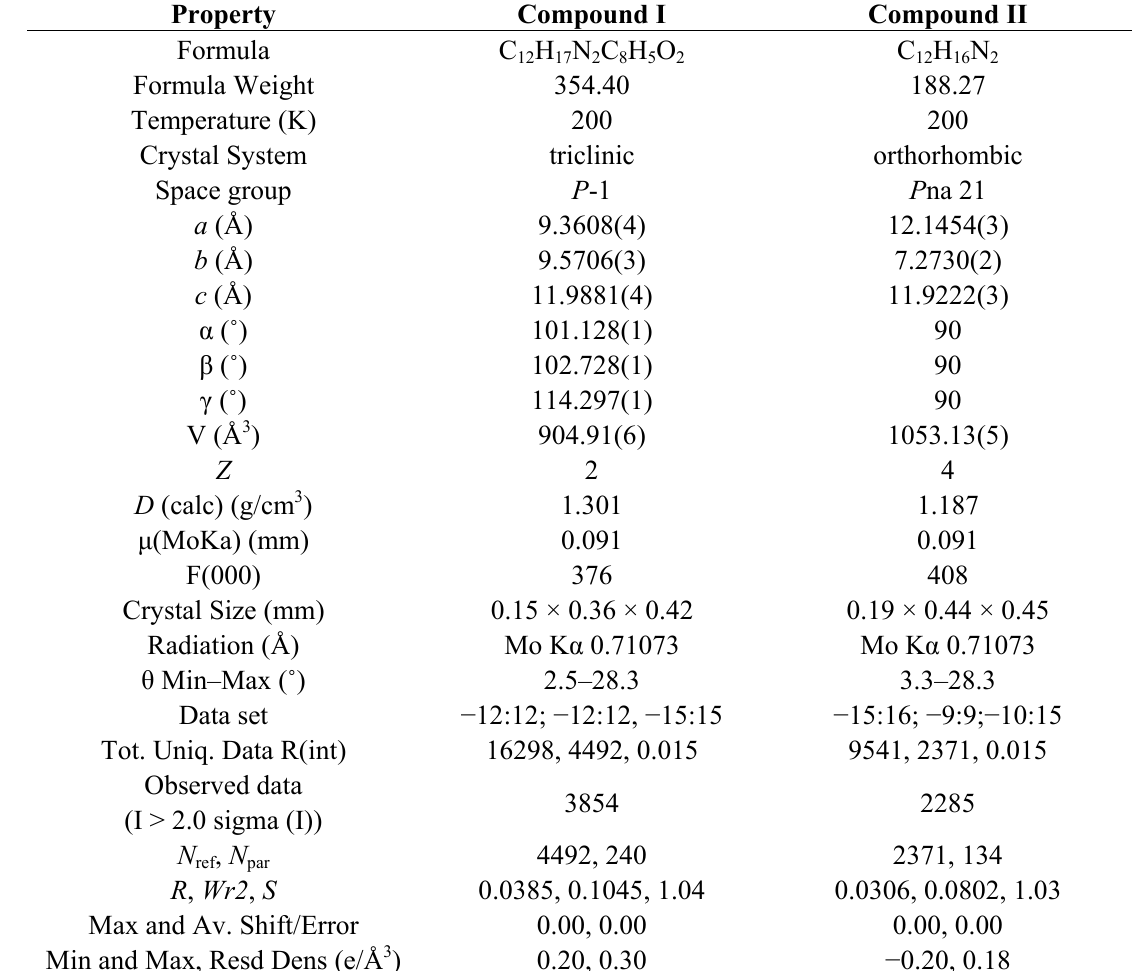
Table 1. Crystallographic data and structure refinement for compounds I and II .